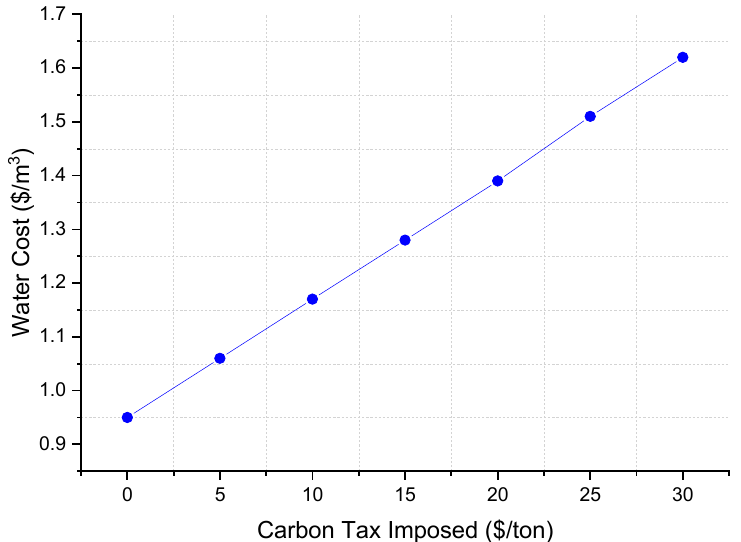
Figure 9. Sensitivity analysis of water cost (USD/m 3 ) versus carbon tax (USD/MWh) for oil-fired steam boilers.